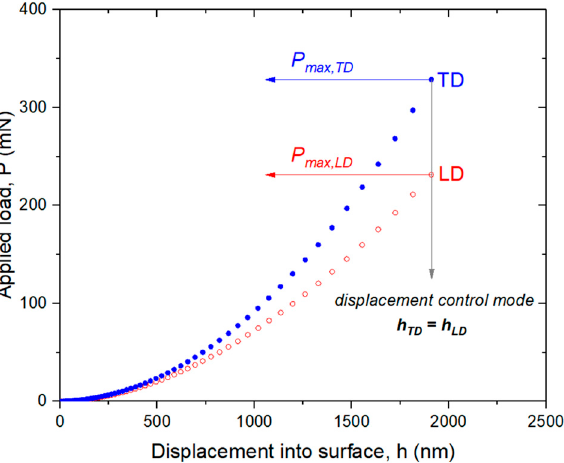
Figure 6. Loading curves for both the orthogonal directions investigated here (LD and TD).